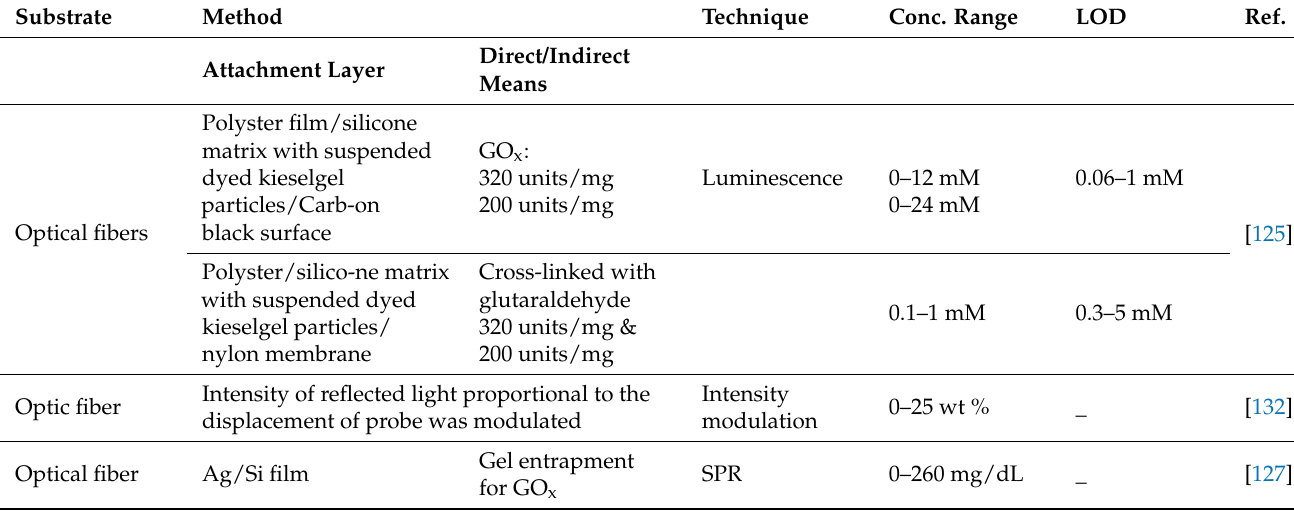
Table 1. Optical fiber sensors reported for glucose